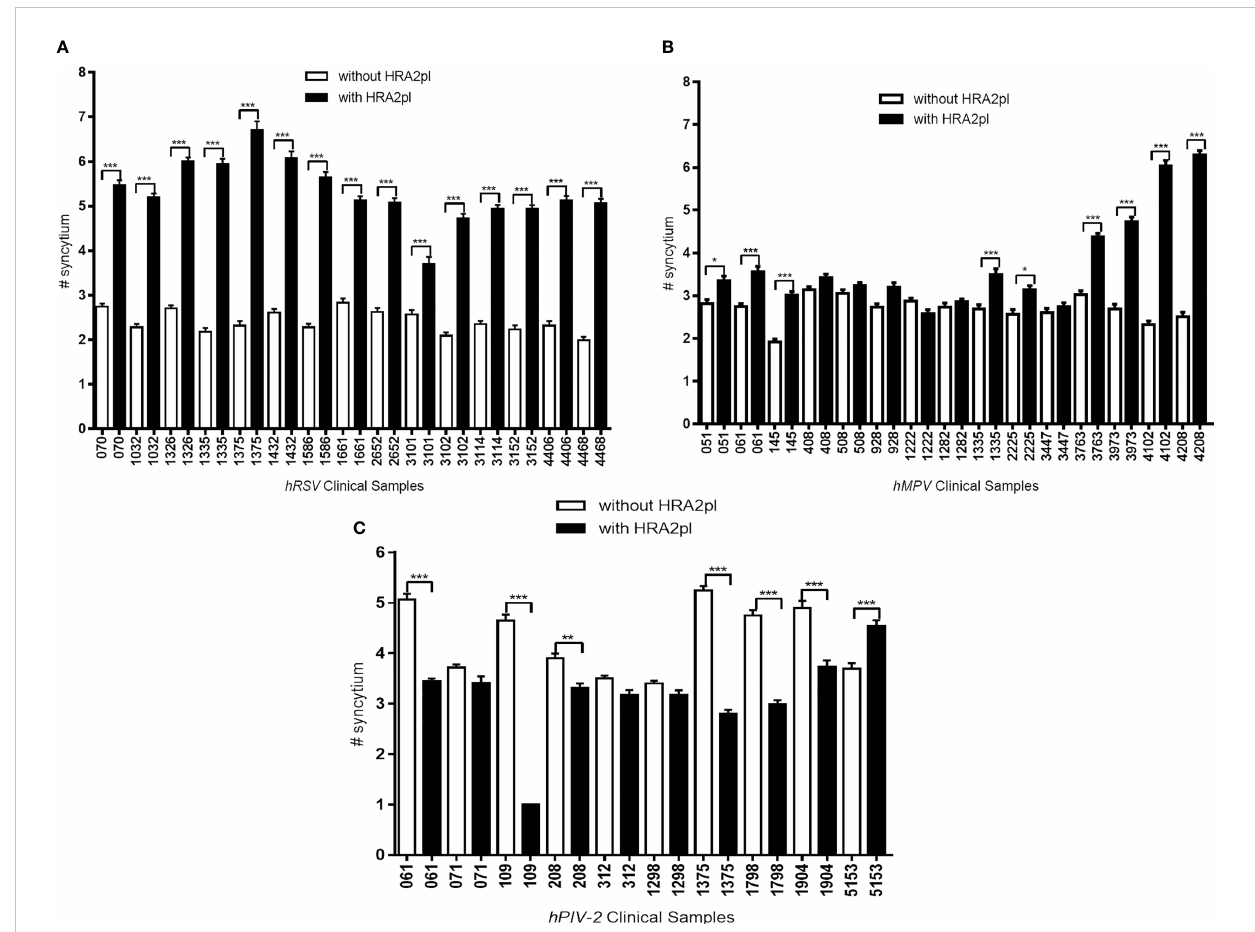
FIGURE 4 The changes in the number of syncytia after HRA2pl B2 treatment varied according to the viral infection. HRA2pl treatment increased the number of syncytia in (A) HEp-2 cells infected with hRSV viral isolates. (B) Some, but not all, HEp-2 cell cultures infected with hMPV viral isolates showed an increased number of syncytia after treatment with HRA2pl. (C) Treatment with the HRA2pl peptide decreased the number of syncytia in Vero cells infected with hPIV-2 viral isolates. NS, Nonsigni fi cant; * p < 0.05; ** p < 0.01; *** p<